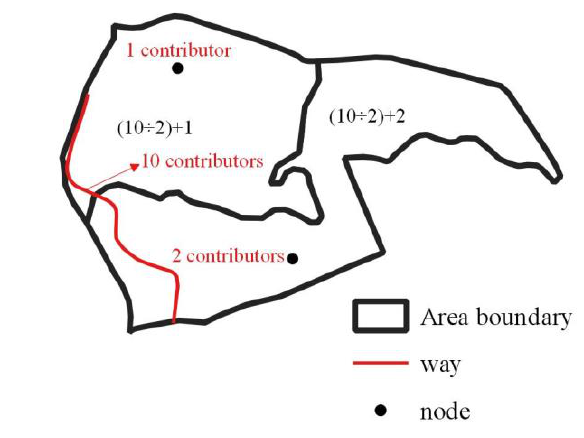
Figure 4. Example of Collective Spatial Intelligence value acquisition